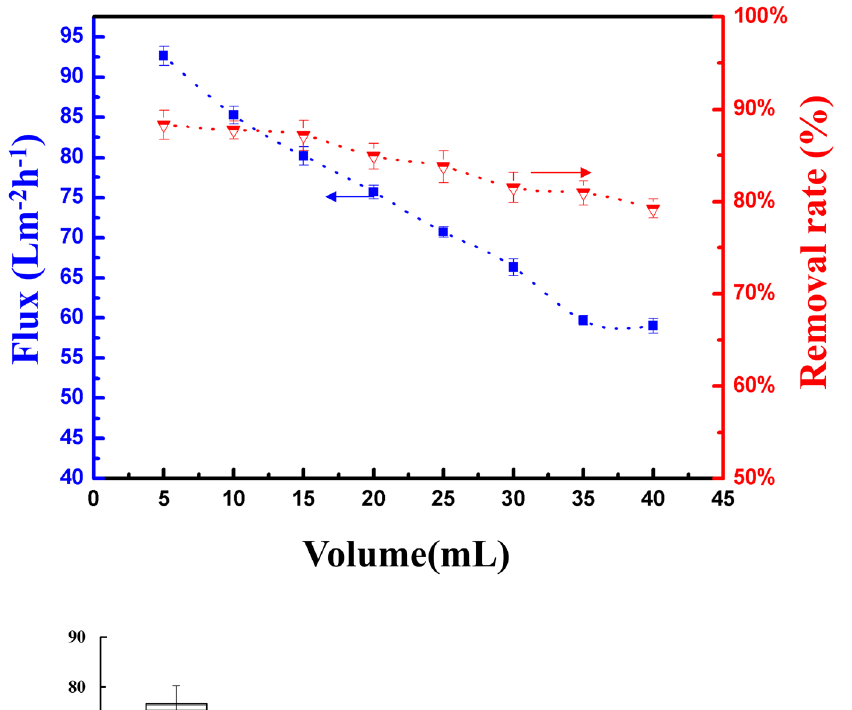
Figure 6. Permeation flux of BDM GO&Laccase@UF under 5 consecutive